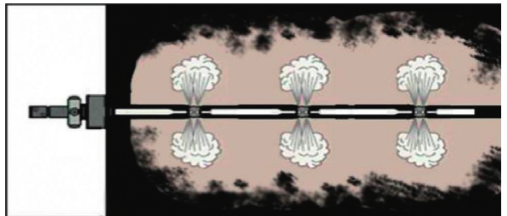
Figure 4: Sketch map of working principle of CO